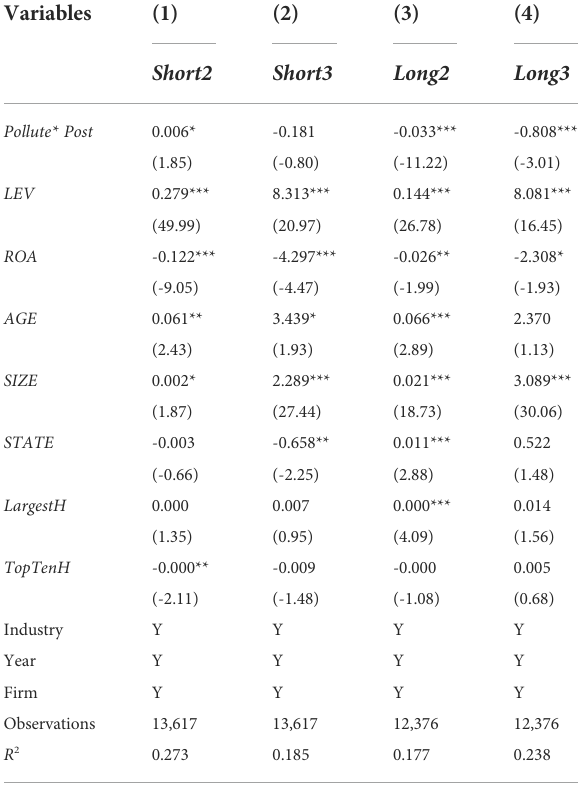
TABLE 9 Replacing metrics of green credit policy on corporate debt fi nancing.